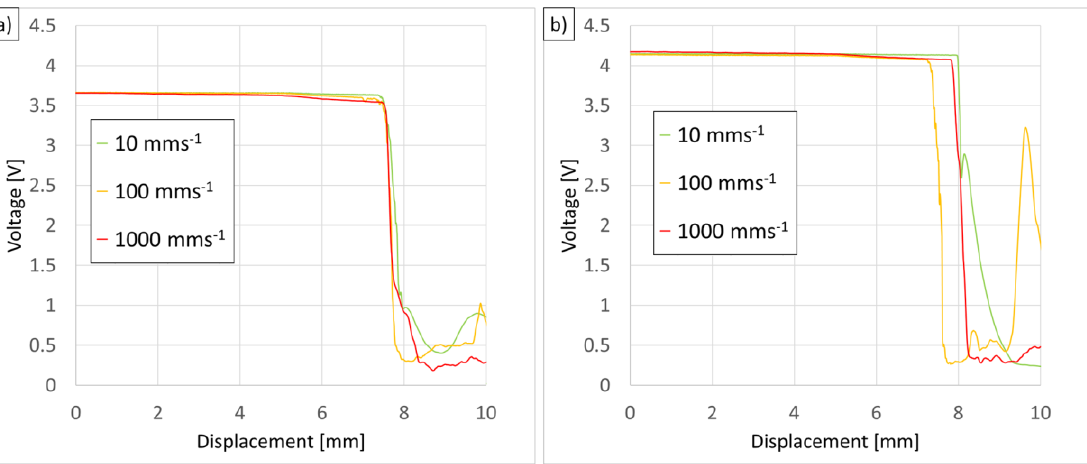
Figure 13. Voltage vs. displacement curves of experiments with different impact velocities and ( a ) 40% SoC and ( b ) 100% SoC.